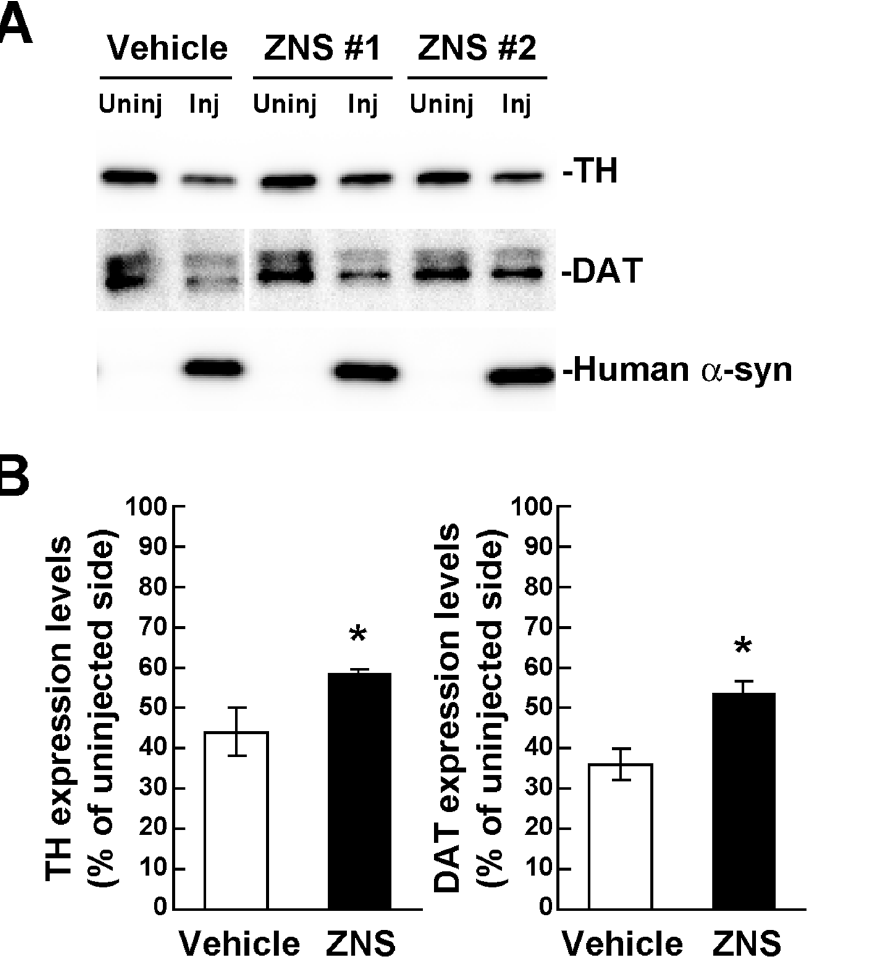
Figure 4. Biochemical analysis of the expression levels of TH and DAT in rats unilaterally injected with rAAV-A53T a -synuclein. The striatum tissues were collected at 4 weeks after viral injection, and divided into the injected and uninjected sides. ( A ) 1% Triton X-100-soluble extracts (10 m g/lane) were analyzed by western blotting with TH, DAT, and LB509 (human total a -synuclein) antibodies. Representative blot data of the vehicle and ZNS groups are shown. Human a -synuclein is observed only in the rAAV-injected sides. Although the DAT blot of vehicle-treated samples is separated from the blot of ZNS-treated ones, these blots are originally derived from the same blot. ( B ) Graphs show the ratios of TH and DAT expression levels in the ZNS group relative to those in the vehicle group. As compared with vehicle treatment, ZNS significantly retained the expression levels of TH (n=4 for each group, P =0.013) and DAT (n=4 for each group, P , 0.001). Data represent the means 6 SD. P -values were estimated by unpaired t test (* P ,